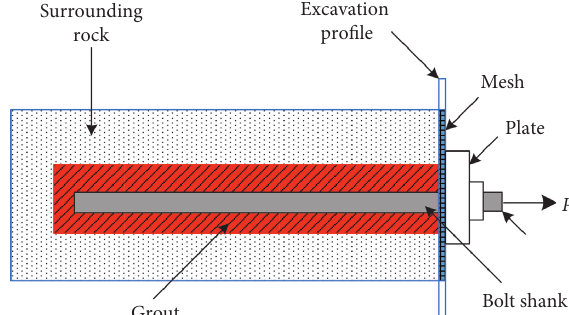
Figure 1: Schematic diagram of a pullout test.